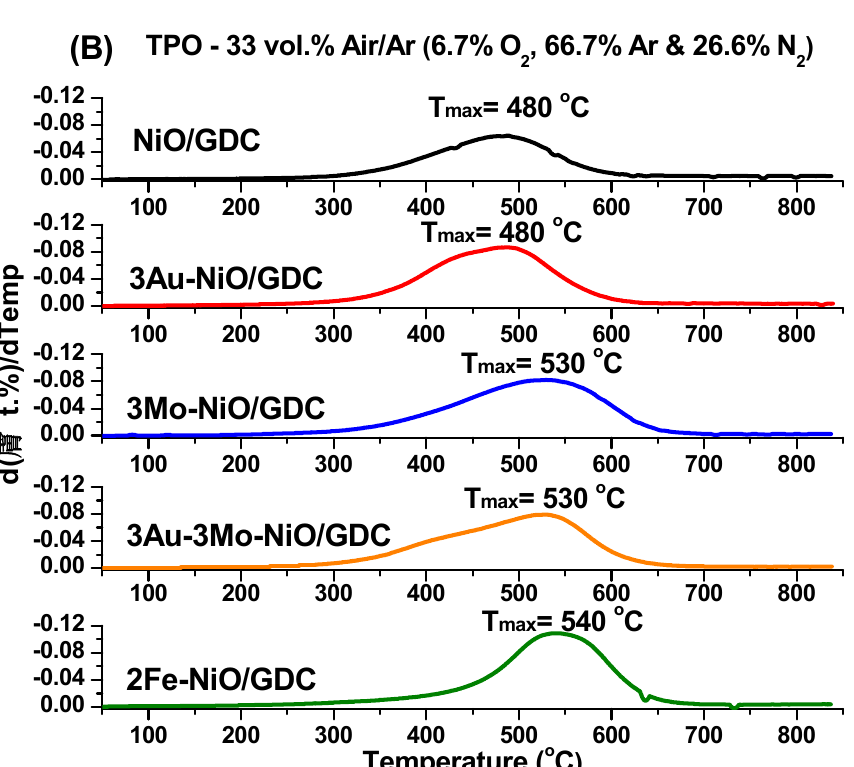
Figure 1. TGA (A) H 2 -TPR (12 vol.% H 2 /Ar), and (B) O 2 -TPO (33 vol.% air) profiles of X-modified NiO/GDC samples (where X= Au, Mo, and Fe). The measurements were performed on powders, calcined at 1100 °C. F total = 60 cm 3 /min (STP conditions: 0 °C, 1 atm).